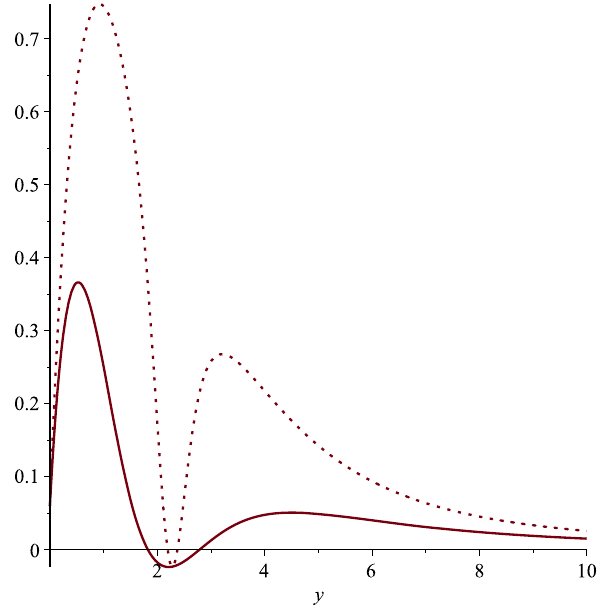
Fig. 12 Plot of the tangential pressure h 2 p ⊥ /μ given in (45) versus y = ( r / h ) 1 /ξ inthecase ξ = 1 / 2andfordifferentvaluesoftherescaled mass μ < μ 0 = 0 . 95206. The solid and dotted lines correspond to the cases μ = 0 . 7 and μ = 0 . 94, respectively. The plot has been obtained by applying 6 . 5 . 29 in [70] to expand the lower incomplete Gamma function in (45) where the first hundred terms in the expansion have been considered. The same behaviour can be observed for all other values of ξ considered in Table 2